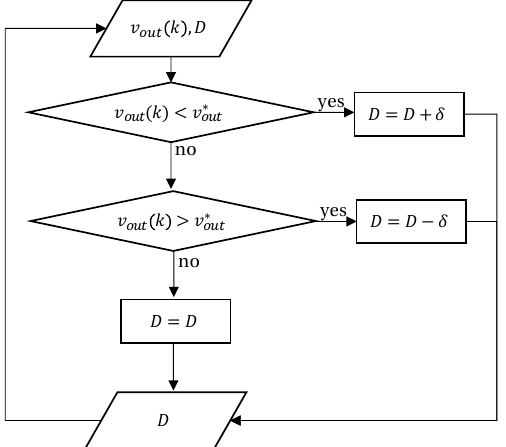
Figure 7. Buck-Boost voltage optimization strategy